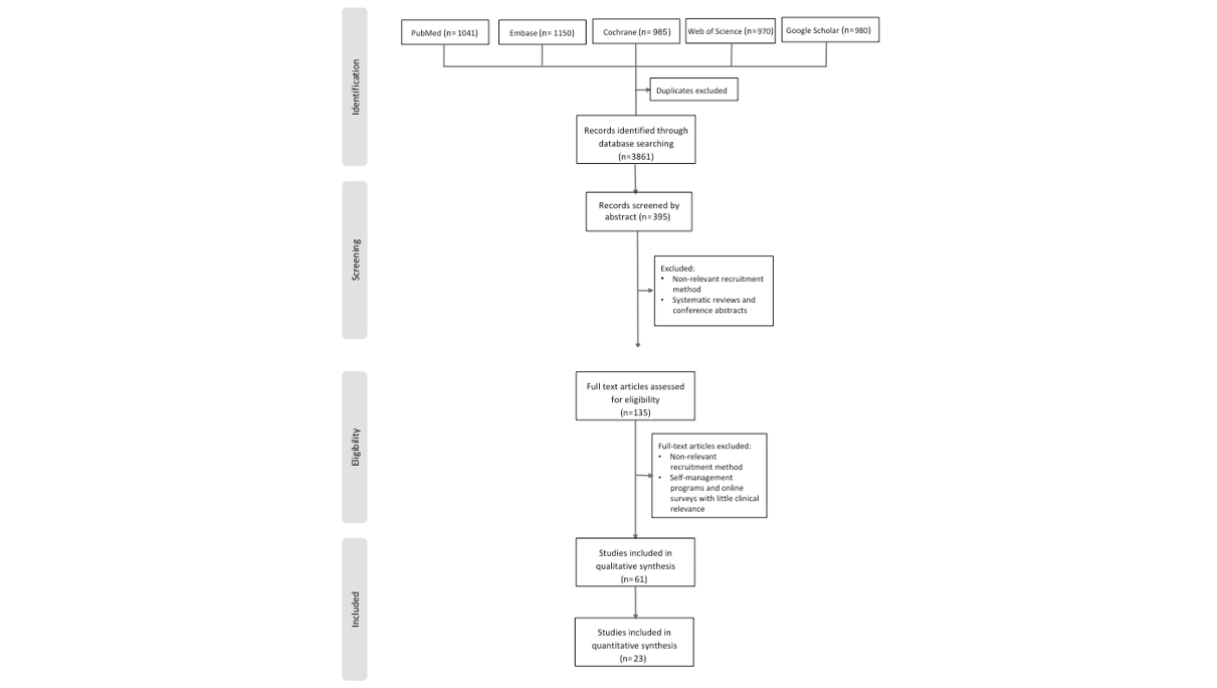
Figure 1. Flow diagram of the literature